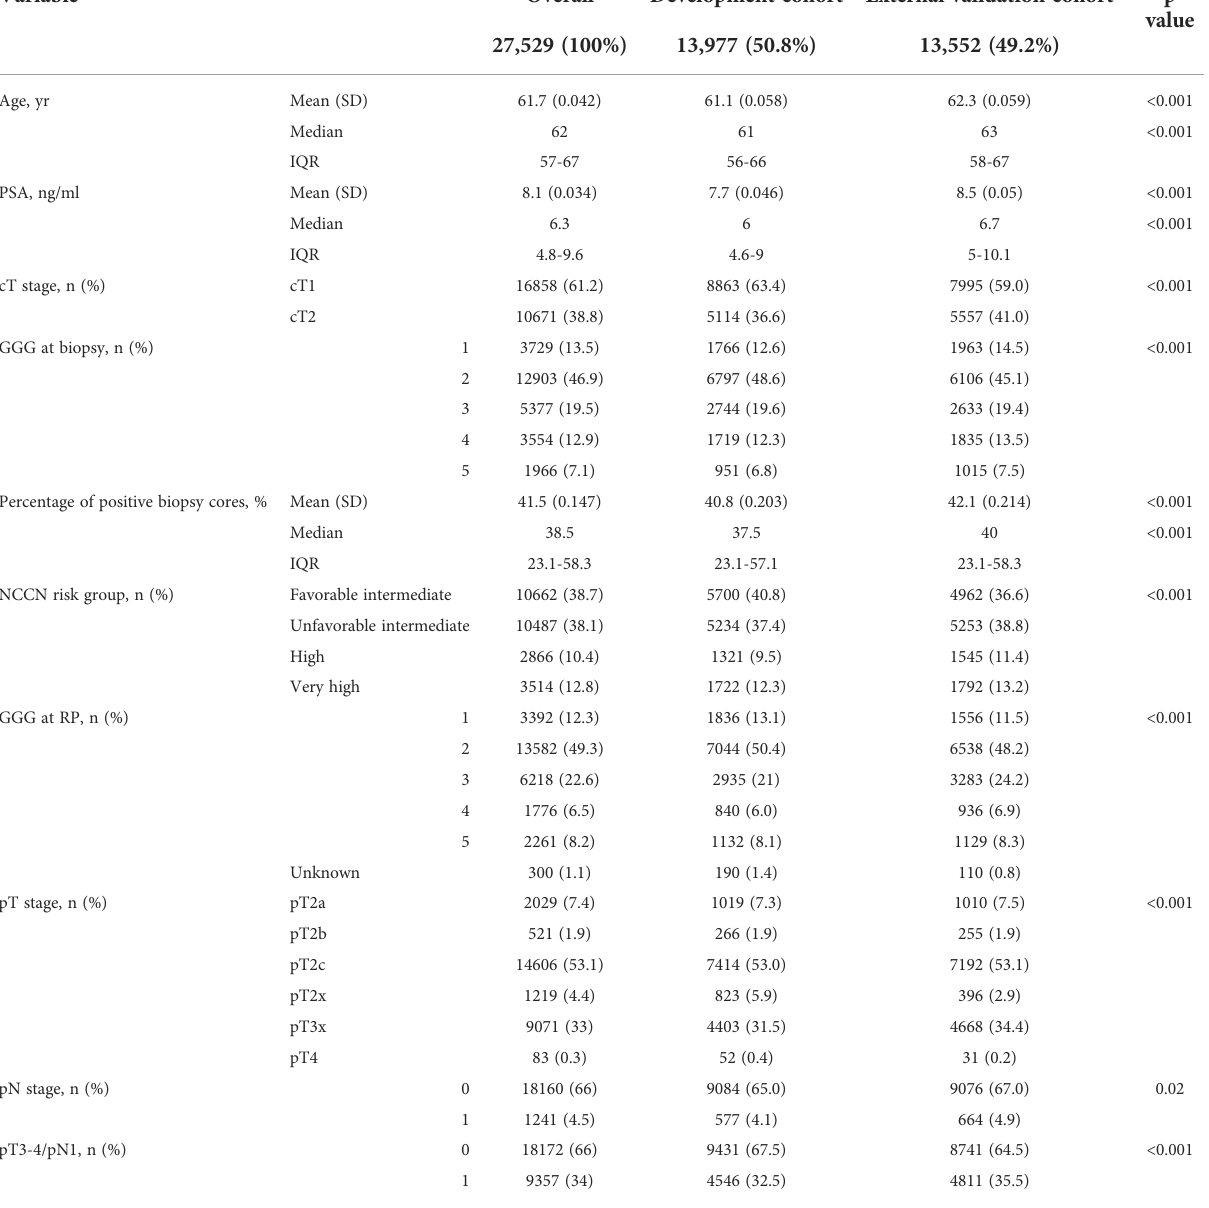
TABLE 1 Descriptive characteristics of 19,193 patients with clinically localized prostate cancer treated with radical prostatectomy between 2010 and 2016, identi fi ed within SEER database.